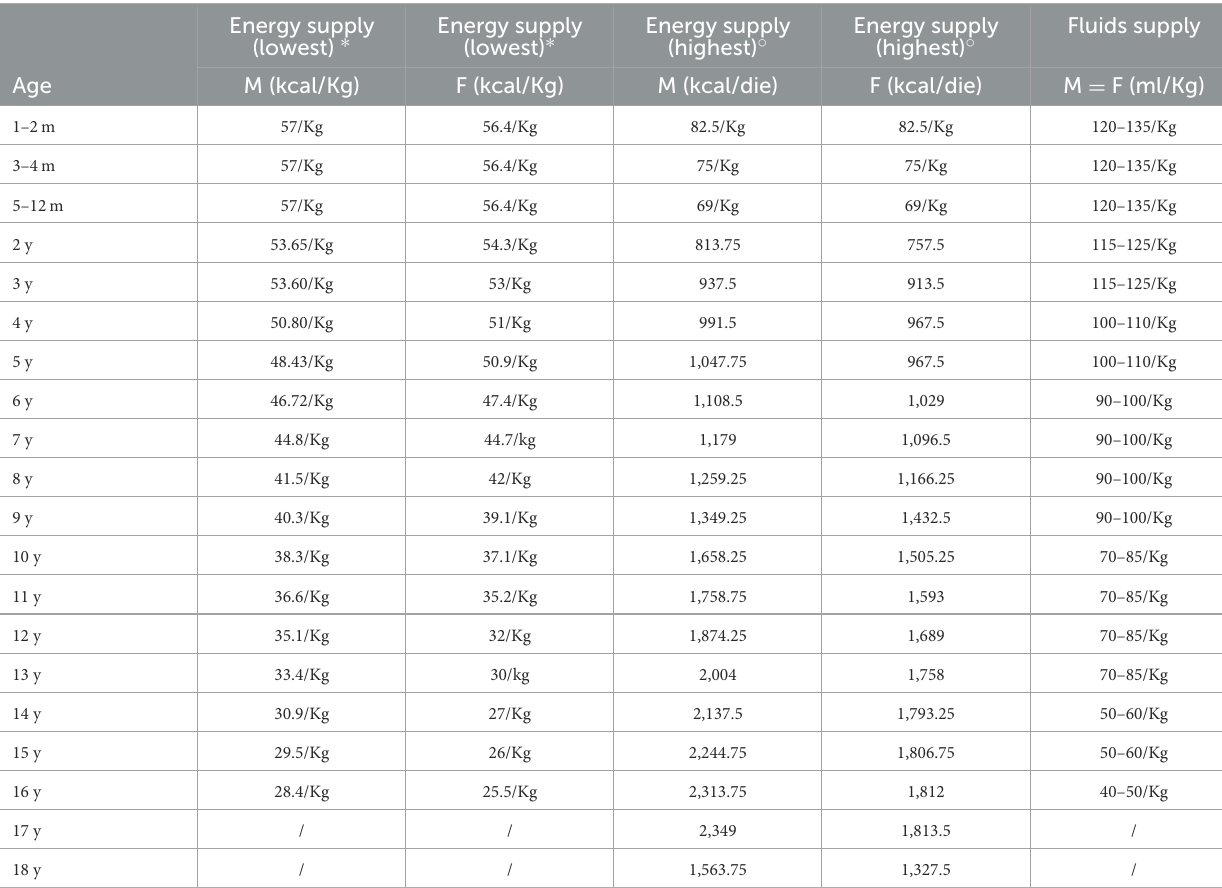
TABLE 1 Protocol for energy and fluid